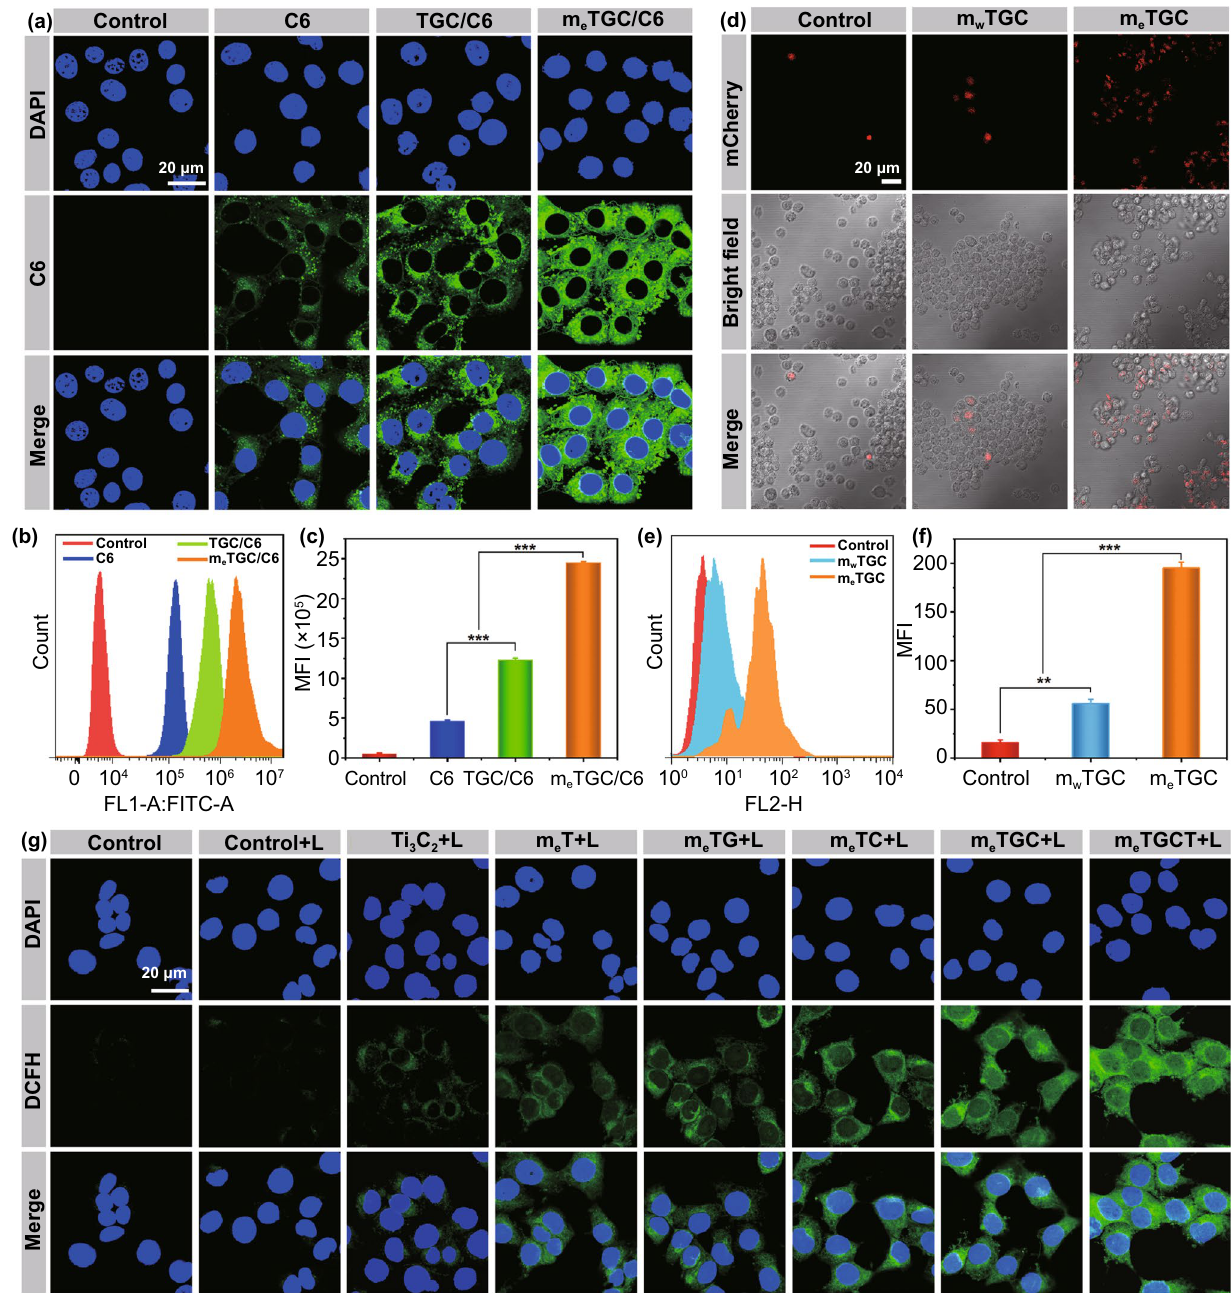
Fig. 4 a CLSM results of 4T1 cells uptake toward TGC/C6 and m e TGC/C6 at 4 h. b Flow cytometric results and c quantitative flow analysis of 4T1 cells uptake of C6-labeled different formulations. d CLSM results of 4T1 cells were swallowed by macrophages after different treatments with m w TGC and m e TGC. e Flow histogram analysis and f quantitative flow analysis of 4T1 cells swallowed by macrophages after treatments with m w TGC and m e TGC. g CLSM results of intracellular ROS level. ( ***p < 0.001, **p < 0.01, n =